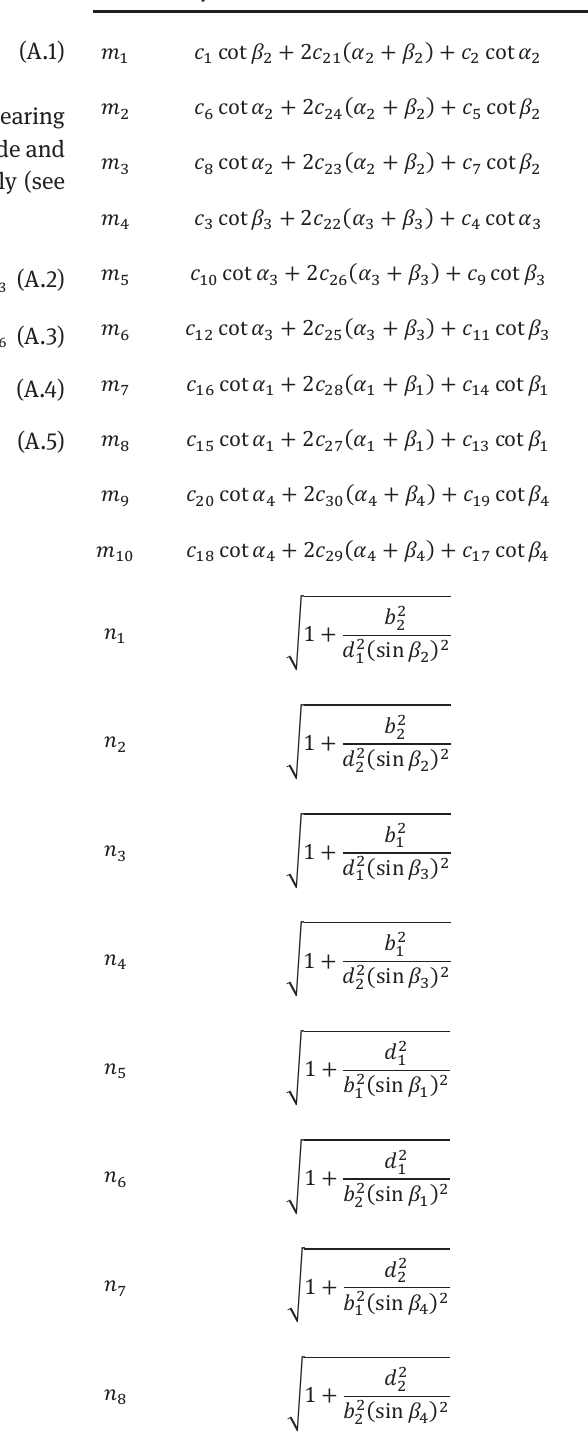
Table A.1: Coefficients from Eq. (A.2)–Eq. (A.5) for rough and smooth foundation base. Note that the undrained shear strengths c defined individually for each dissipation region (for more details see Chwała, 2019a).